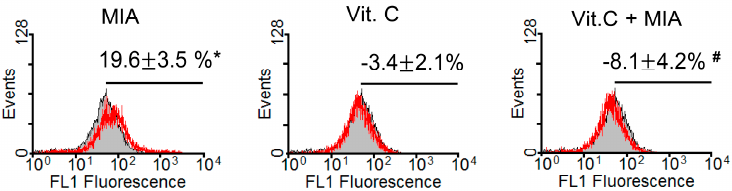
Figure 2. Effects of MIA and/or vitamin C on oxidative stress in SW1353 cells. SW1353 cells were incubated with 100 μ M vitamin C in the presence or absence of 5 μ M MIA for 8 h, and then production of reactive oxygen species was measured using 2 ′ ,7 ′ -dichlorofluorescein diacetate (DCFH-DA) and flow cytometry. The percentages above the panel indicate the percentage of cells showing DCFH-DA fluorescence (reactive oxygen species generation) and are the mean ± S.D. for three separate experiments, each in triplicate. The gray filled area is the untreated control and those delimited by the red lines are the treated groups. * p < 0.05 compared to the untreated control group. # p < 0.05 compared to the MIA treated group.